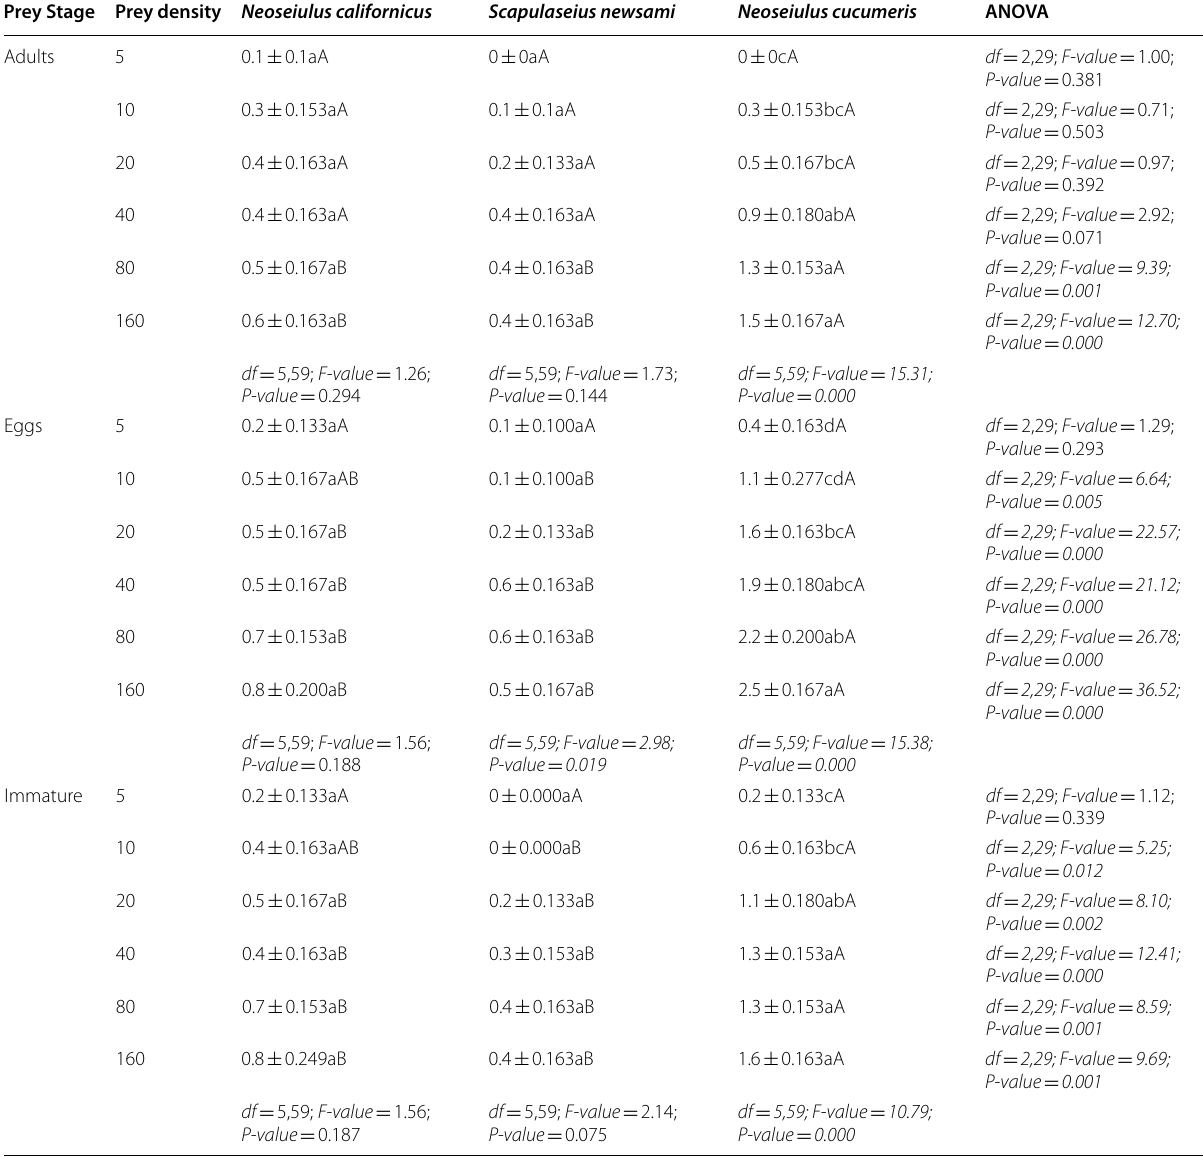
The means followed by different small letters in the table are significantly different ( P < 0.05, Tukey’s test) in the same column, the values followed by different capital letters in the table are significantly different ( P < 0.05, Tukey’s test) in the same line. The values are presented as mean